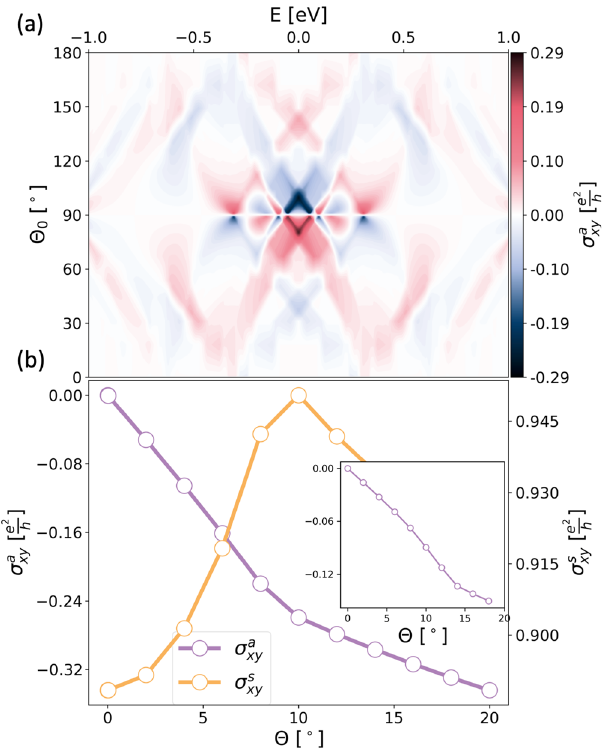
Fig. 3 Properties of the chiral Hall effect. a Behavior of the antisymmetric part of the anomalous Hall conductivity σ a xy at 10° canting as a function of Fermi energy and direction of collinear ferromagnetic magnetization s 0 = ( θ 0 , 10°). While the fi ne structure of the chiral Hall effect correlates with the band structure dynamics in response to canting and rotation of the initial magnetization, the origin of the effect in the Weyl point at half fi lling for θ 0 = 90°, serving as a source of staggered mixed Berry curvature, is visible. b The scaling of the crystal (orange line) and chiral (violet line) Hall effects with the canting angle θ at half- fi lling of the ferromagnetic case s 0 = (100°, 10°). The inset displays the scaling of the chiral Hall effect with θ for Fermi energy E = − 1.5 eV in the antiferromagnetic case with the F same s 0 . between the antisymmetric Berry curvature and the electronic structure: as visible in (Fig. 2h, k) the emergence of strong features in the Berry curvature of the fi rst band of the model is consistent with the fi rst and second band coming close to each other in energy at speci fi c points in the BZ. In analogy to